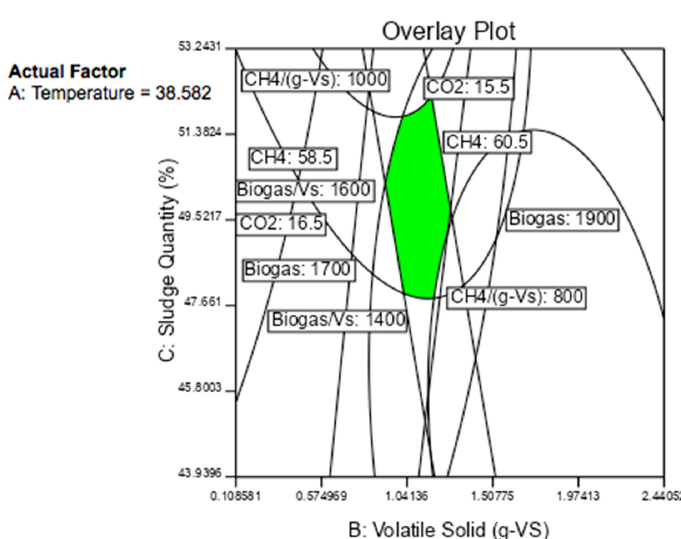
Figure 19. Overlay plot based on the first criterion. Energies 2020 , 13 , x; doi: FOR PEER REVIEW